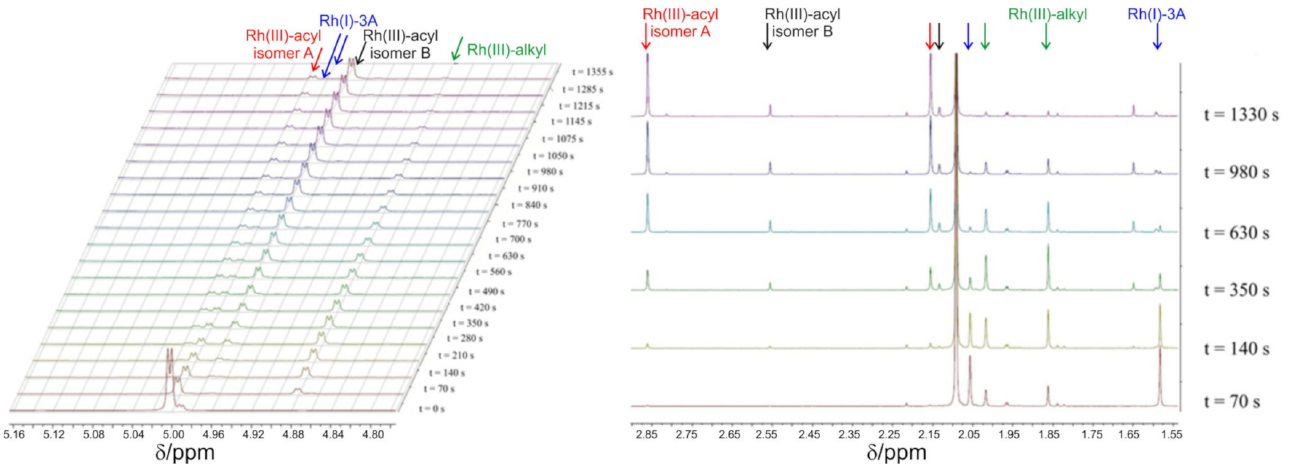
Figure 6. Stacked 1 H-NMR spectra of the reaction between the [Rh(CH 3 COCHCNHCH 3 )(CO)(PPh 3 )] 3A complex and CH 3 I, focusing on the methine ( left ) and methyl ( right ) proton signals at 25 ◦ C. The